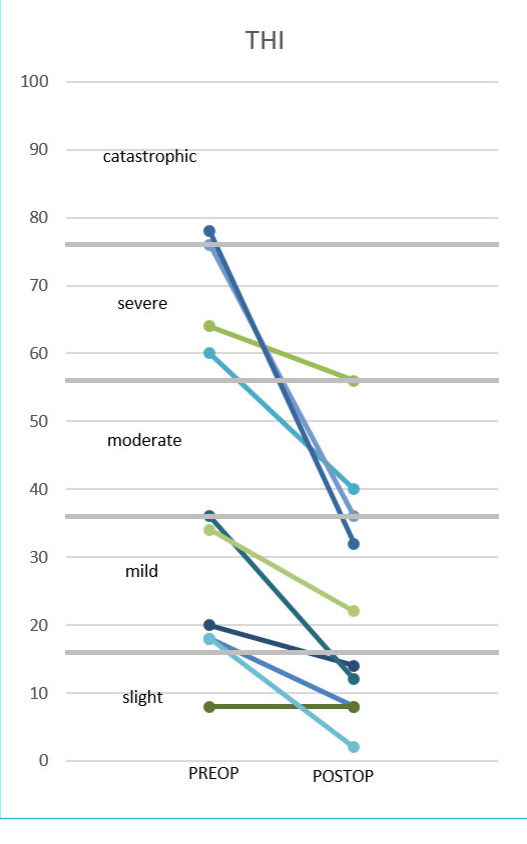
Figure 8: Individual Tinnitus Handicap Inventory (THI) scores as- sessed preoperatively and 12 months after activation.